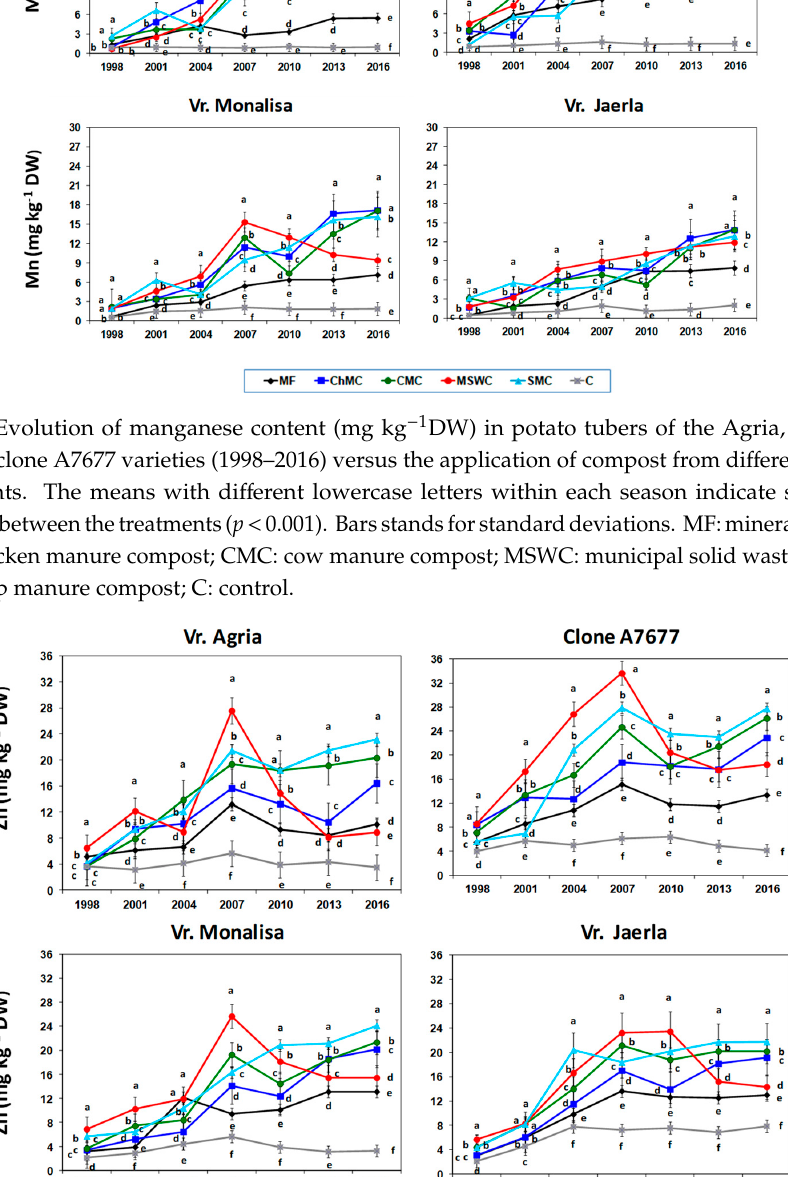
Figure 9. Evolution of zinc content (mg kg − 1 DW) in potato tubers of the Agria, Monalisa, Jaerla and clone A7677 varieties (1998–2016) versus the application of compost from di ff erent organic amendments. The means with di ff erent lowercase letters within each season indicate significant di ff erences between the treatments ( p < 0.001). Bars stands for standard deviations. MF: mineral fertilizer; ChMC: chicken manure compost; CMC: cow manure compost; MSWC: municipal solid waste compost; SMC: sheep manure compost; C: